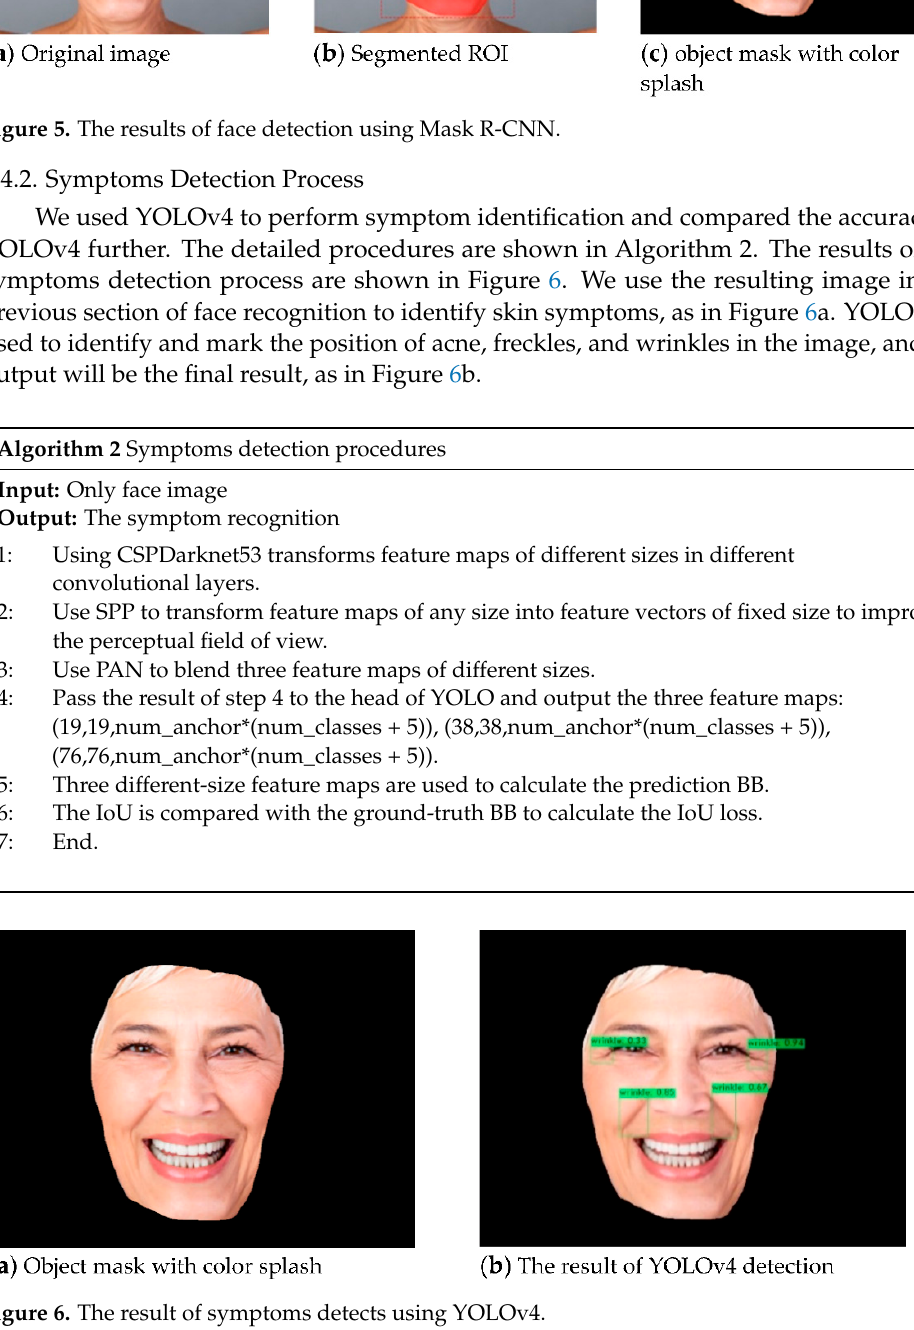
Figure 6. The result of symptoms detects using YOLOv4.